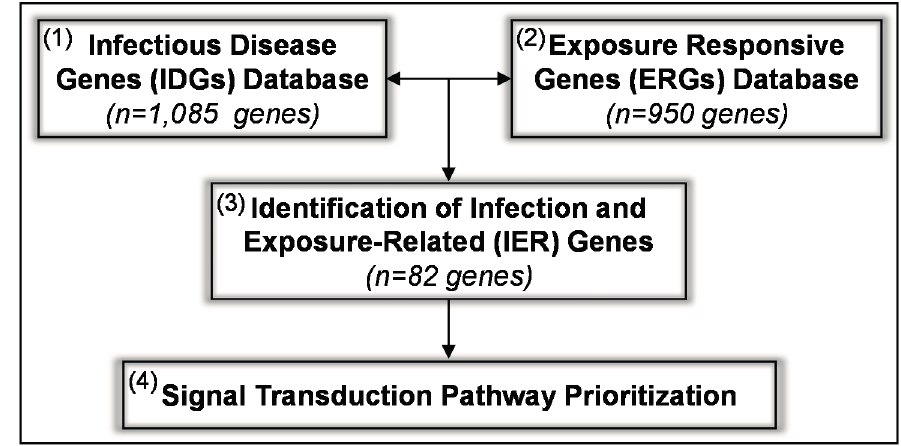
Figure 1. The Comparative Genomic Enrichment Method (CGEM) was used to identify key genes and proteins and their corresponding signal transduction pathways likely involved in exposure-associated modifications in infectious disease-related signaling. The CGEM consists of four steps: (1) Identification of the infectious disease gene (IDG)